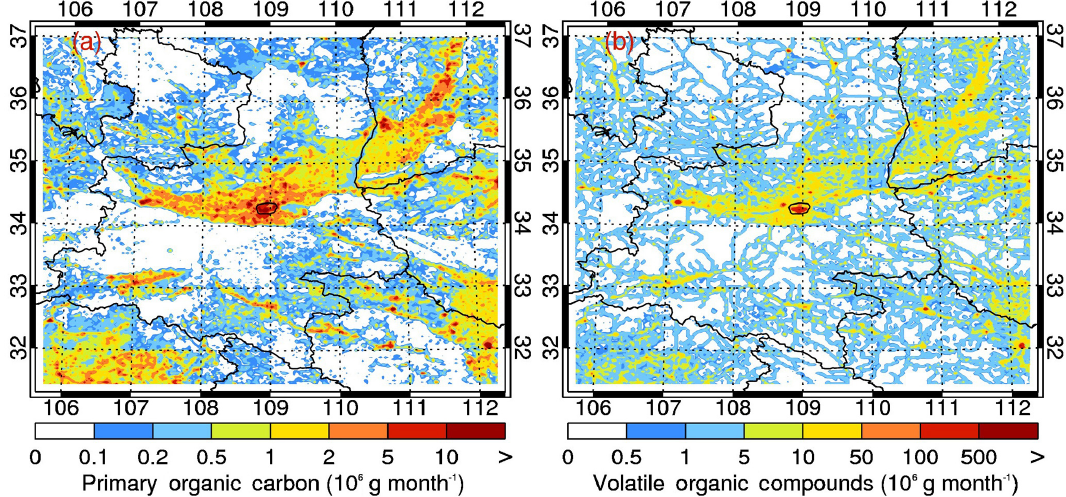
Figure 2. Geographic distributions of anthropogenic emissions of (a) primary organic aerosol and (b) volatile organic compounds in the simulation domain. The black lines present provincial boundaries in China.